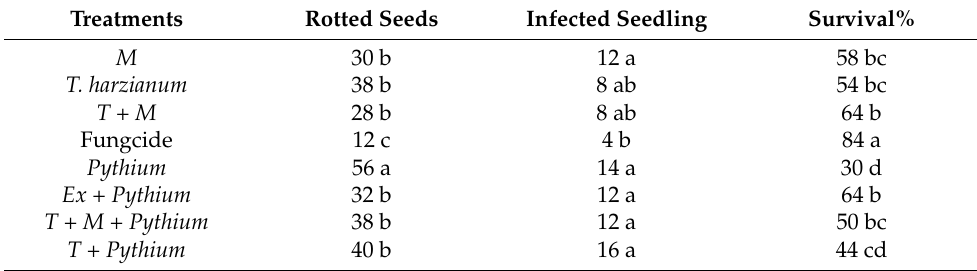
Table 2. The percentage of rotted seeds and infected seedlings as well as survival plants of Phaseolus vulgaris as response to different